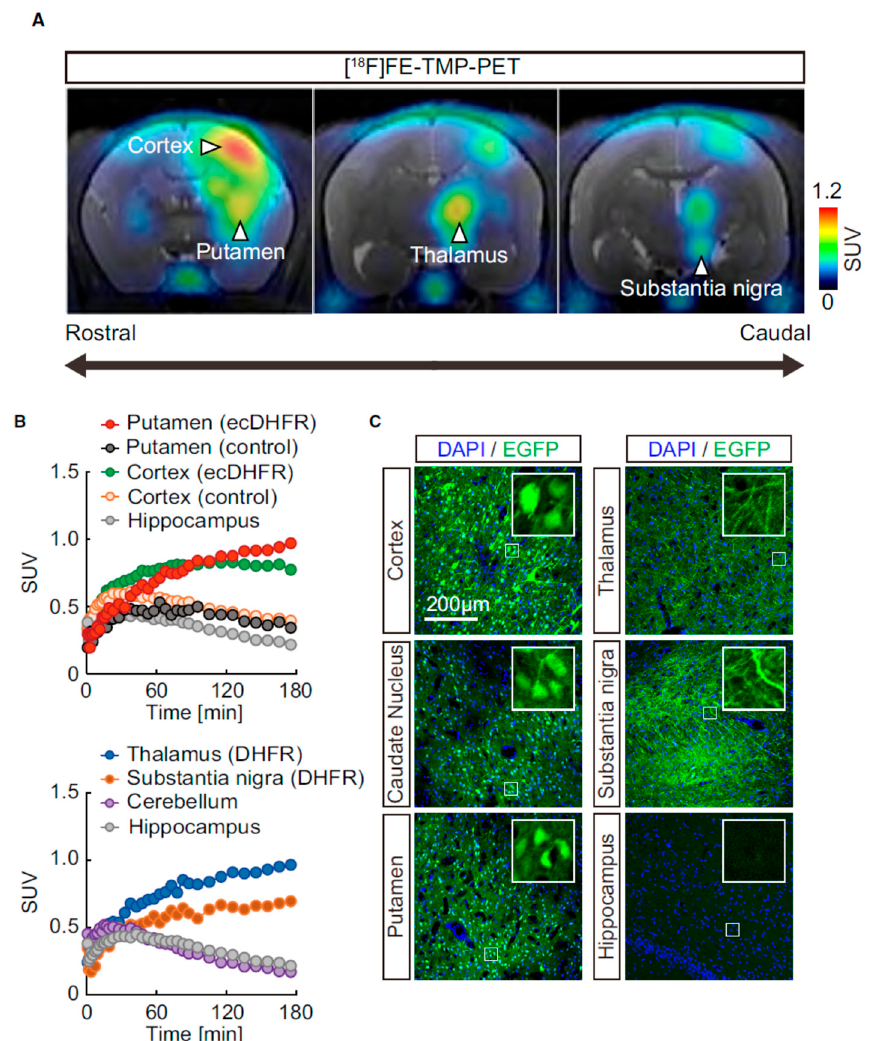
Figure 6. PET imaging of ecDHFR/TMP reporters in primate brain. ( A ) Representative coronal PET images generated by averaging dynamic scan data at 60–180 min after i.v. injection of [ 18 F]FE-TMP. Note that reporter molecules were densely distributed in thalamus and substantia nigra pars compacta, which are connected to the neocortex and putamen via direct neuronal tract, respectively. PET images are overlaid with an individual MRI. Scale bar represents the SUV. ( B ) Time–radioactivity curves for [ 18 F]FE-TMP in the putamen and neocortex carrying ecDHFR-EGFP or control AAV, and in the hippocampus are displayed in the upper panel. Curves in the thalamus, substantia nigra, and cerebellum along with hippocampus data are also shown in the lower panel. ( C ) Postmortem analysis of ecDHFR-EGFP expression in brain slices of different part with high-magnification image frames in inserts. Reproduced with permission from the authors (2021) [57].